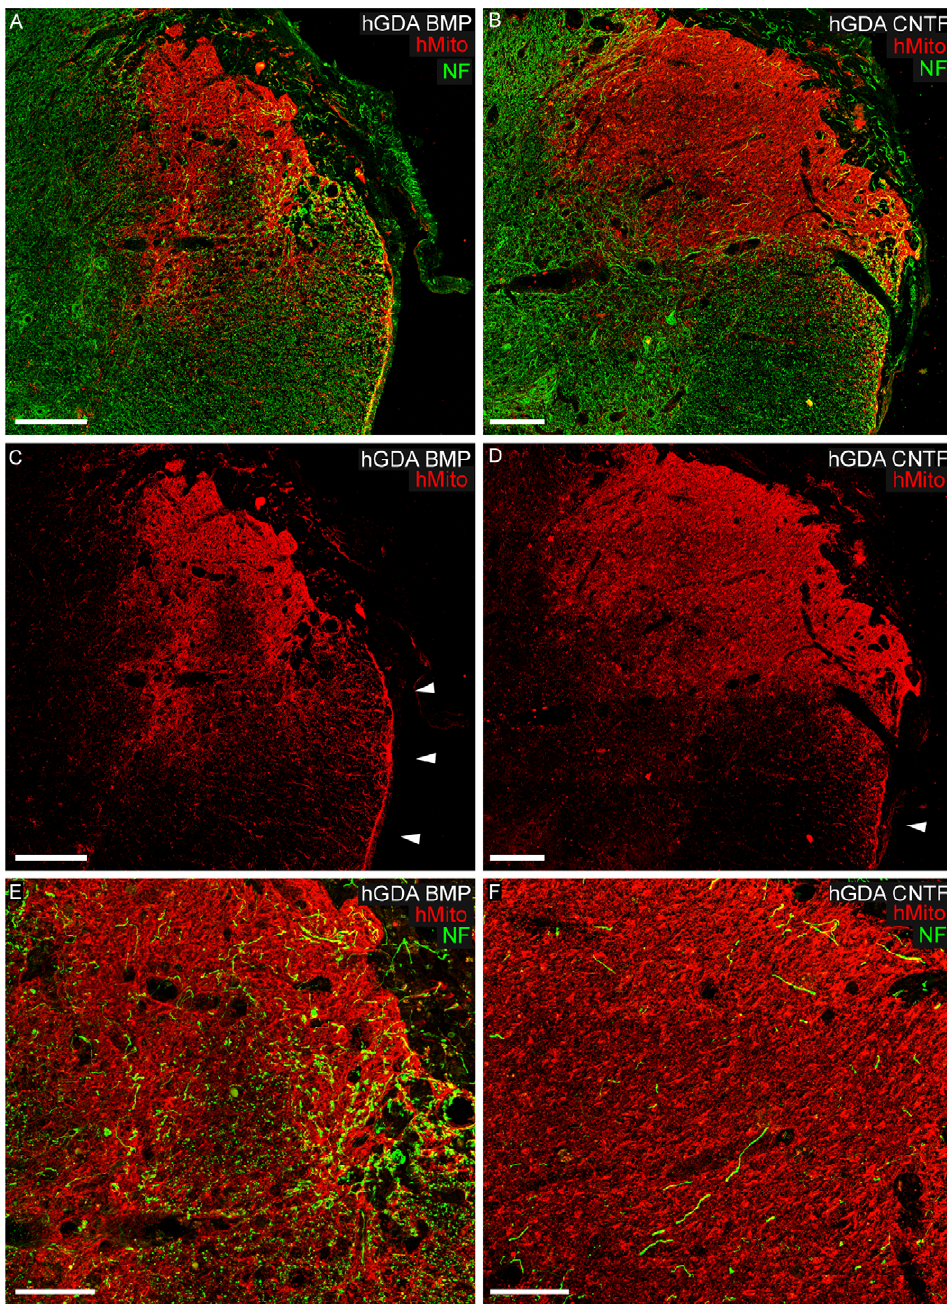
Figure 2. Human GDA graft survival and support of axon growth within spinal cord DLF injuries. Immuno-staining for human mitochondrial marker (red channel) of histological cross sections at sites of injury revealed hGDAs BMP (A, C, E) and hGDAs CNTF (B, D, F) transplant masses spanning the dorsal-ventral and lateral-medial margins of injury sites. Arrowheads in C and D indicate accumulations of hGDAs BMP and hGDAs CNTF respectively at the pial surface of lateral funiculus white matter (see also Fig. 4 A, B). Co-labeling for neurofilament (NF: green) and human mitochondrial marker (hMito: red) shows a markedly higher density of axons within hGDAs BMP treated injury sites (A, E) compared to hGDAs CNTF treated injury sites (B, F). Greater numbers of NF + axons within hGDAs BMP transplants aligned with the normal rostral/caudal trajectory of DLF white matter (E) compared to NF + axons within hGDAs CNTF transplants (F). Survival=5 weeks post injury/transplantation. Scale bars: A, B, C, D=200 m m; E, F=100 m m.